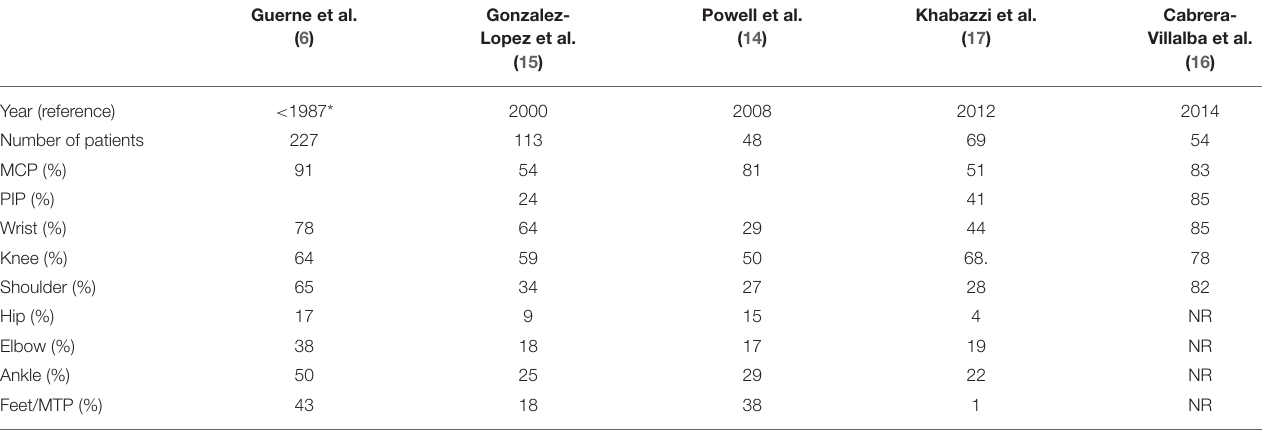
MCP, metacarpophalangeal; PIP, proximal interphalangeal; MTP, metatarsophalangeal.